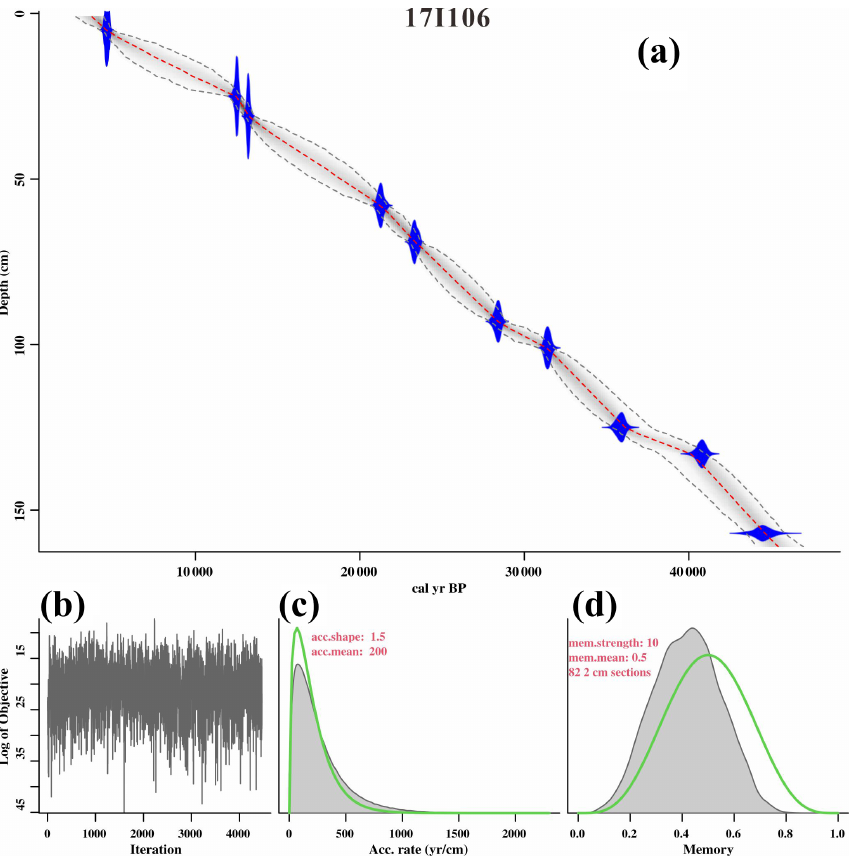
Figure 2. Age–depth model of core 17I106 in the northeastern Indian Ocean. (a) Calibrated 14 C dates (blue, with 2 σ errors) and the resulting age–depth model (the darker gray shading indicates more likely calendar ages, the gray stippled lines show 95% confidence intervals, and the red curve shows the single “best” model based on the weighted mean age for each depth). (b) Number of Markov chain Monte Carlo (MCMC) iterations used to generate the grayscale graphs. (c) Prior (green) and posterior (gray) distributions of the sediment accumulation rates (the mean sediment accumulation rate was ∼ 2yrcm − 1 ). (d) Prior (green) and posterior (gray) memory distributions (dependence of the sediment accumulation rate between neighboring